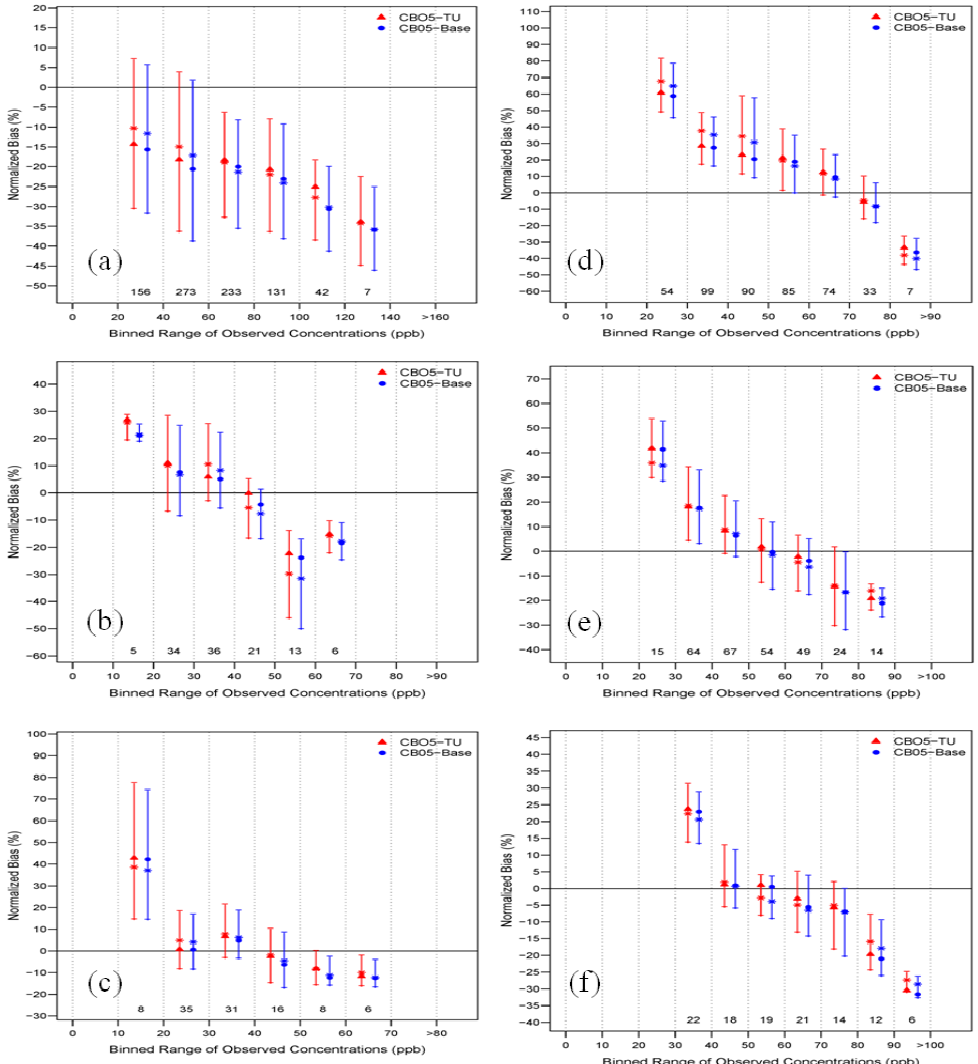
Figure 8: The median and inter-quartile range of mean normalized bias for the daily maximum 8- hr O with CB05-TU and CB05-Base: (a) Los Angeles (b) Portland (c) Seattle (d) Chicago (e) 3 New York/New Jersey (f) Detroit. Number beneath each paired evaluation represents the total sample number in each binned range of observed concentration.